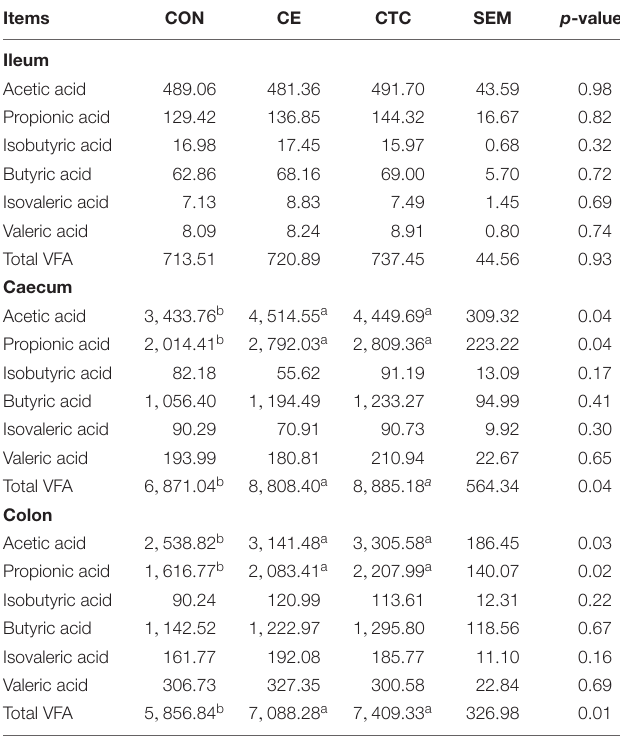
TABLE 6 | Effect of CE on VFA content in different intestinal segments of weaned piglets (mg/kg). Items CON CE CTC